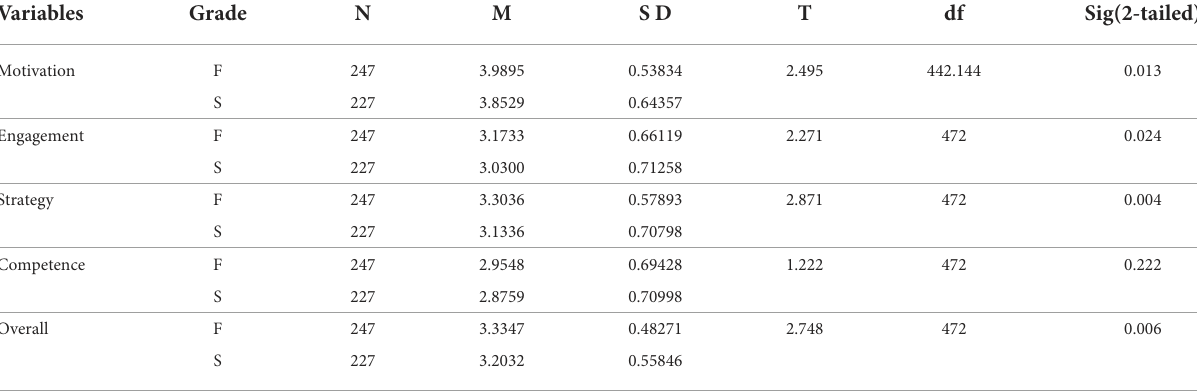
TABLE 7 Independent samples t -test of students’ deep learning across grade groups.